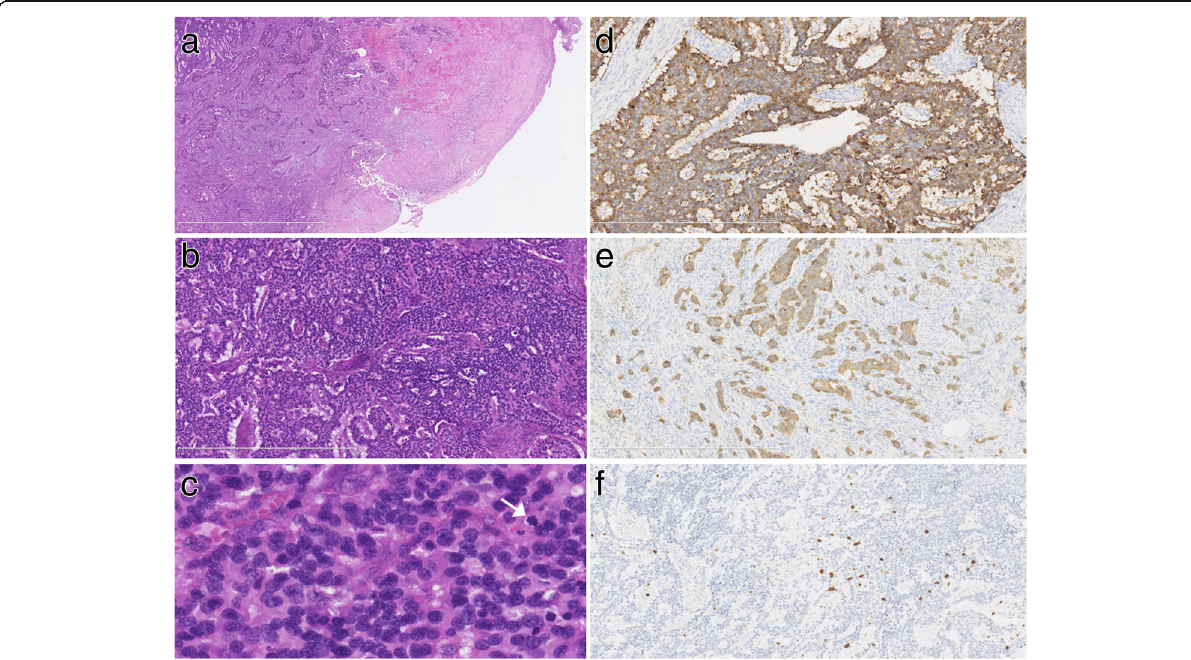
Fig. 1 ( a ) The tumor infiltrated into the deep muscular layers. (HE; original magnification, × 25) ( b ) The tumor took the form of nest-like, trabecular and rosette-like structures. (HE; original magnification, × 100) ( c ) The tumor cells had relatively abundant eosinophilic cytoplasm and nuclei containing dense granular chromatin. The mitotic figure was observed. (HE; original magnification, × 400) ( d ) Immunohistochemically, the tumor cells were positive for Cg A. ( e ) Immunohistochemically, the tumor cells were positive for Syn. ( f ) The index of Ki-67 was 5%. (d-f immunohistochemical staining; original magnification, × 100)